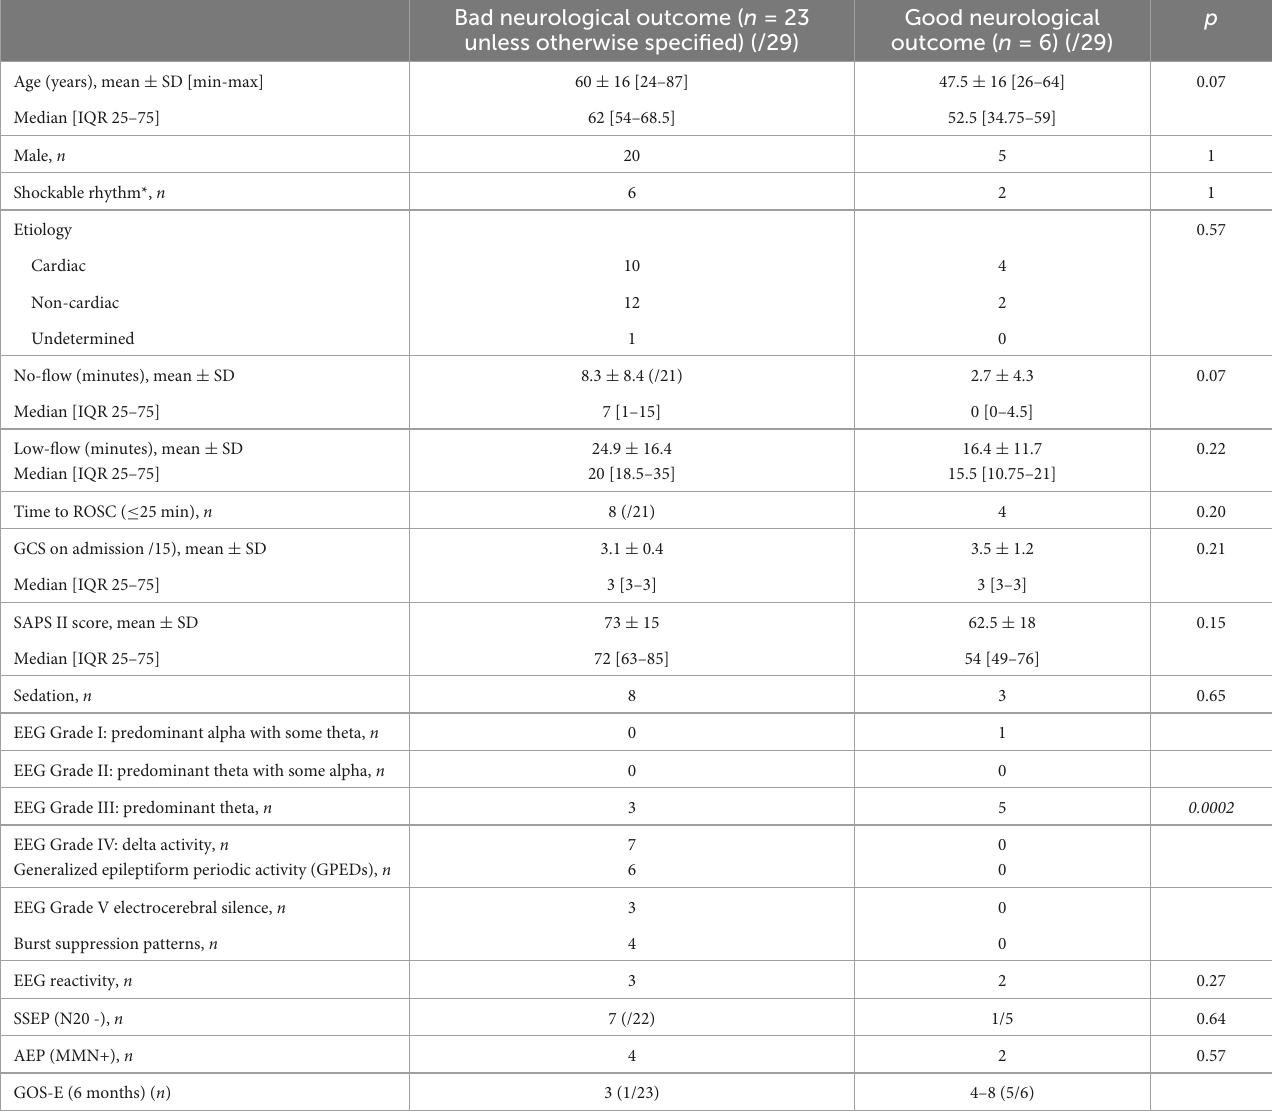
TABLE 1 Comparison of clinical and electrophysiological characteristics between the two groups.